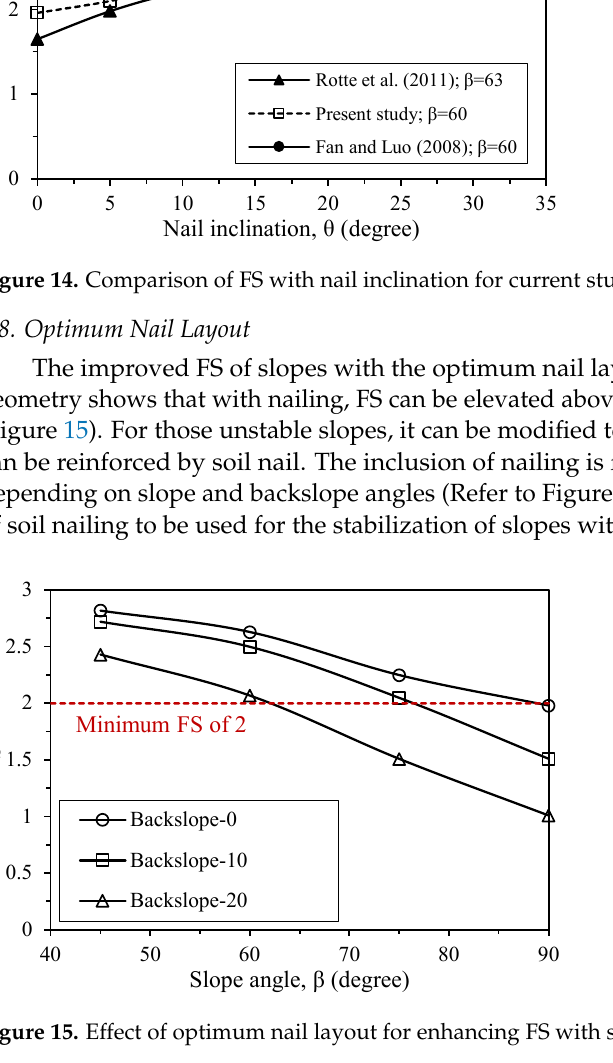
Figure 16. Percent increase in FS for various slope geometries due to soil nailing with optimum nail parameters. 3.9. Wall Facing Soil nails should be connected to a facing system at the excavation face or slope sur- face. The combination of soil nails and facing should be dimensioned to sustain the ex- pected maximum destabilizing force. There are different facing types that are available for a nailed slope system. Shotcrete facing is typically less costly than the structural facing required for other wall systems [64]. A bioengineering technique using vegetation can be used as a substitute for structural facing, which is effective for controlling the erosion and sloughing of the soil at the slope surface [10,65–67]. However, the use of this technique should be limited to non-critical structures where large vertical deformation and horizon- tal deformation are acceptable. 4. Conclusions This study has been carried out to find the optimum nail layout for stabilizing the slopes effectively. The effect of the nail parameters—nail inclination, length, spacing, and forces—on slope stability has been investigated through FE analysis. The effectiveness of soil nailing has been studied, and an optimum design nail layout is found out for stabili- zation. Based on the analyses carried out in the study, the following conclusions can be drawn: 